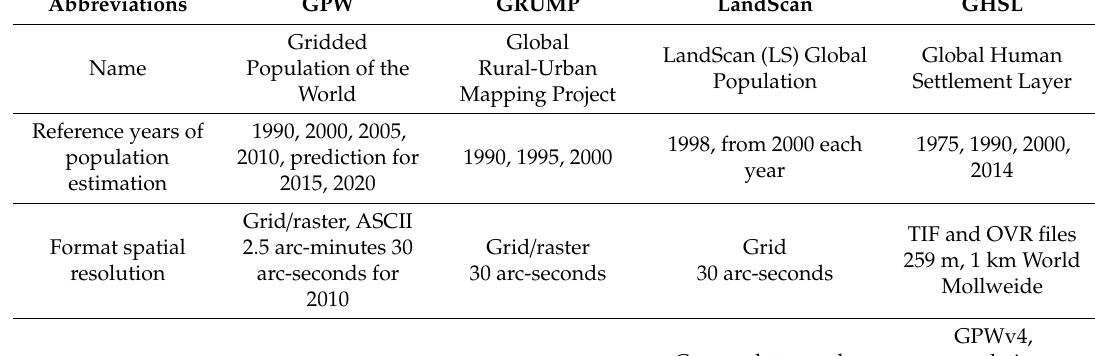
Table 1. Overview of global population